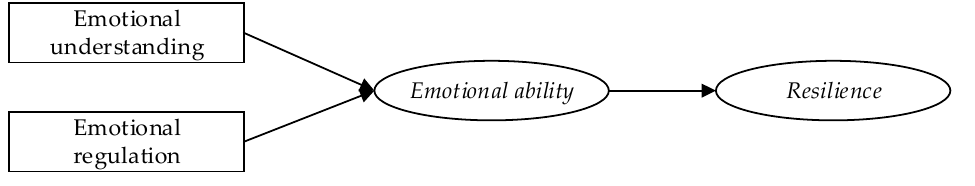
Figure 1. Hypothesis model.